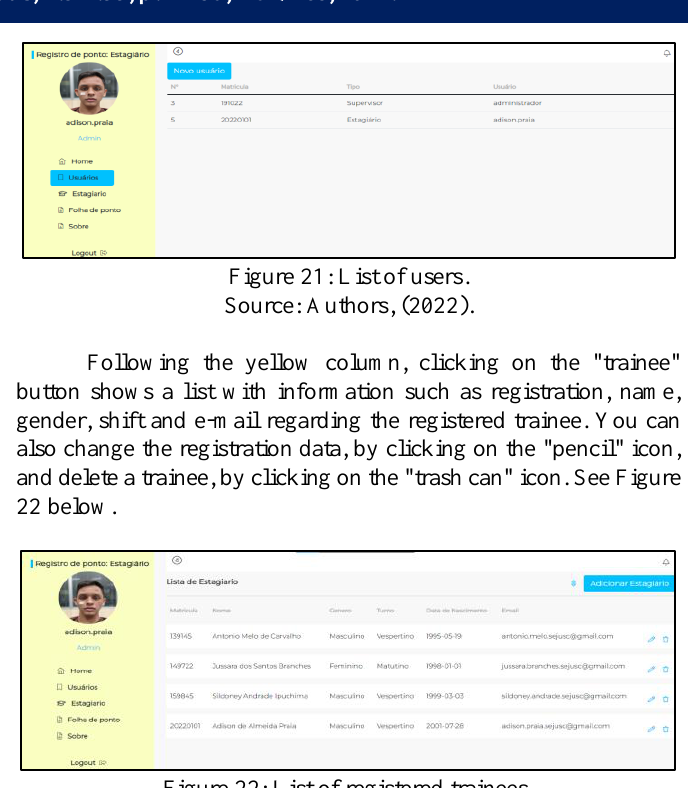
Figure 22: List of registered trainees.